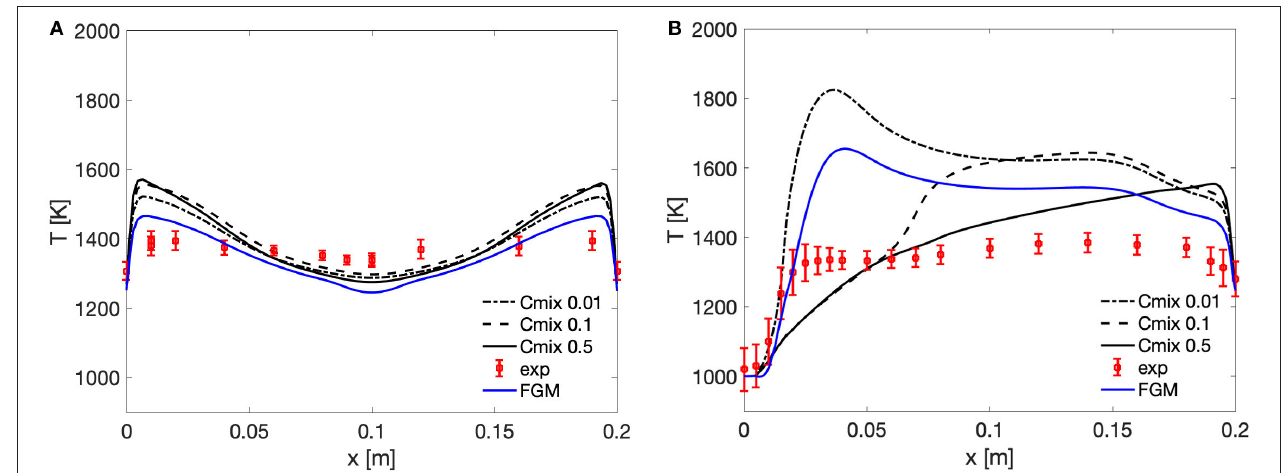
Frontiers in Mechanical Engineering |